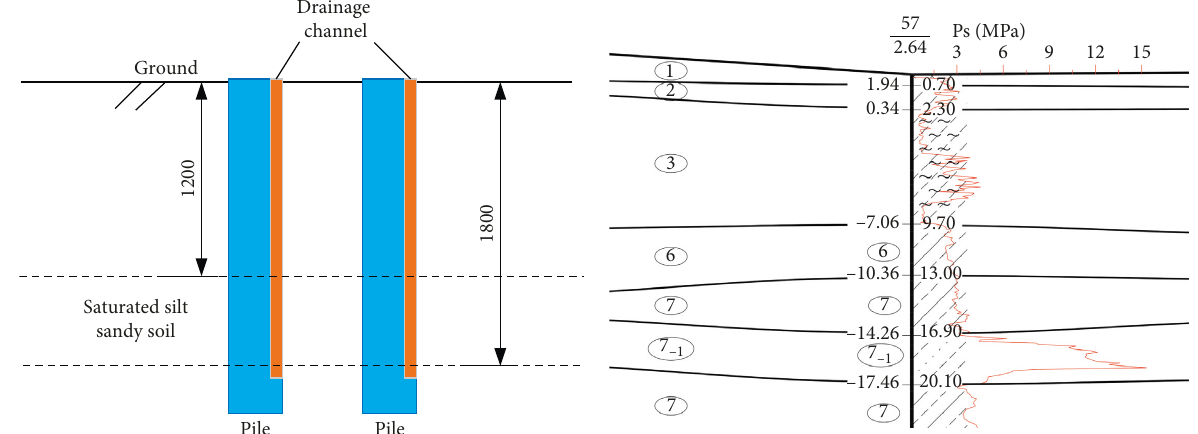
Figure 3: Geological